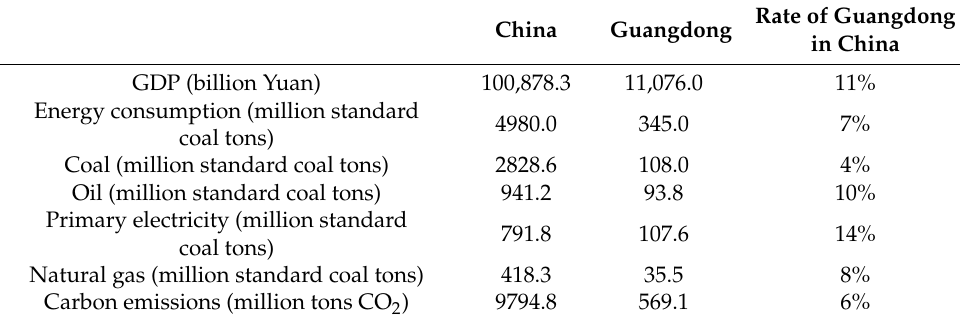
Table 1. China and Guangdong energy and economy indicator in 2020.